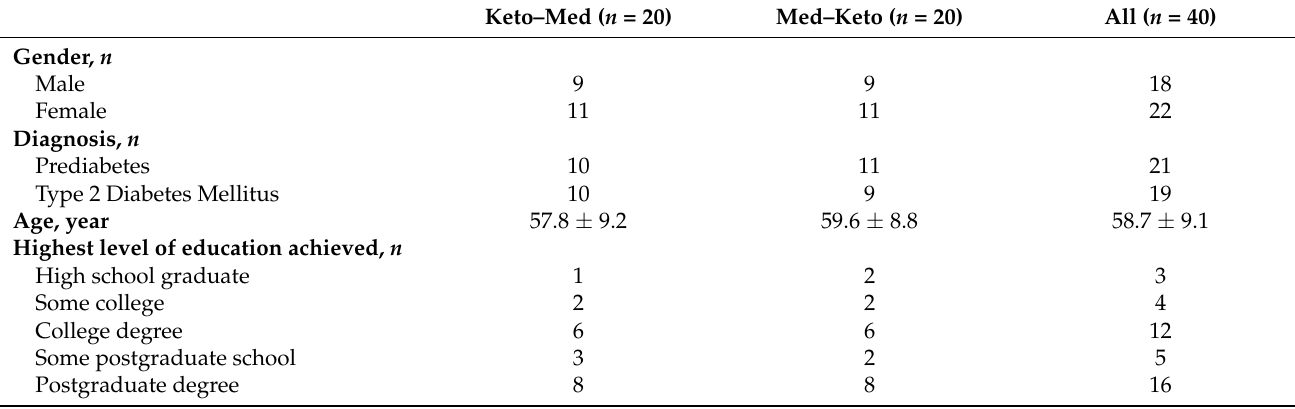
Table 2. Keto–Med Randomized Trial Participants’ Baseline Sociodemographic, Anthropometric, and Metabolic Characteristics 1